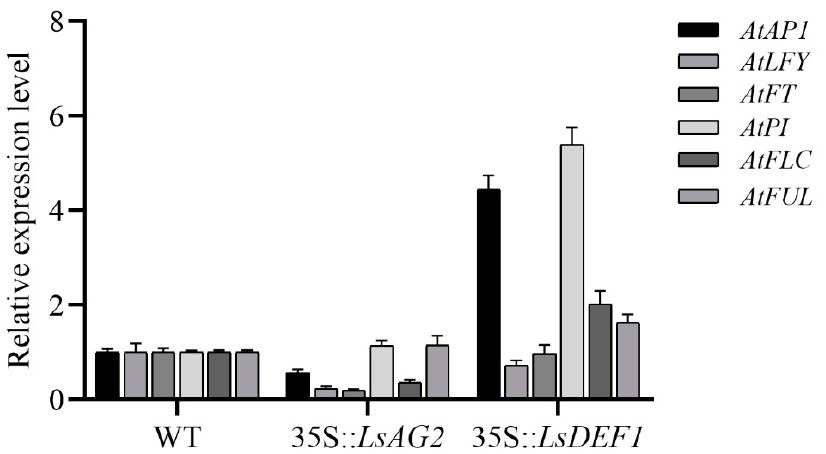
Figure 5. Expression levels of endogenous genes related to the flower time and flower development. The wild-type was selected as the control, and the gene expression levels were calculated using the 2 − ∆∆ Ct method.